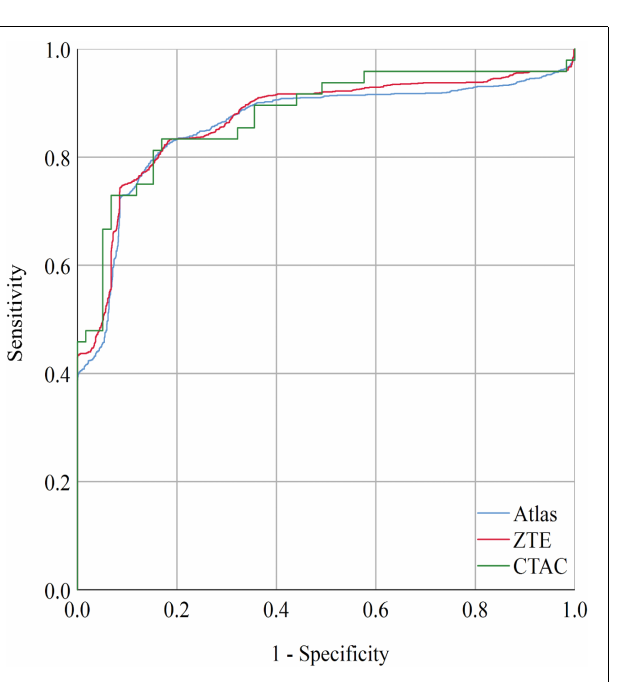
maps derived from each MRAC method. The results show the PETscore based on both Atlas and ZTE were underestimated compared with the original PETscore based on CTAC. ZTE